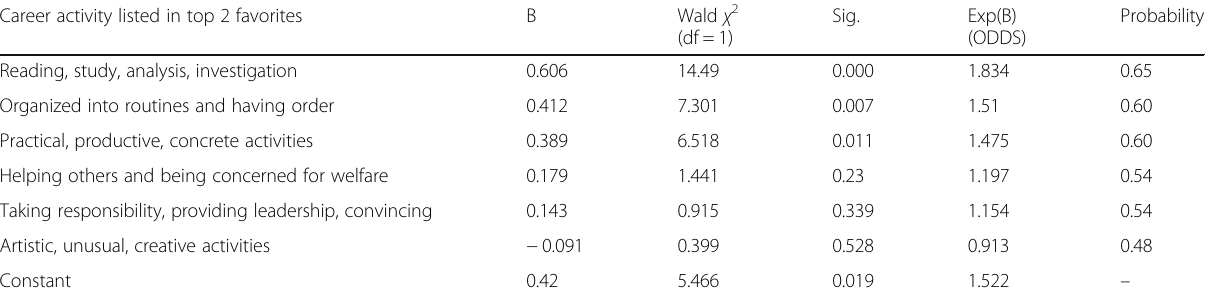
Table 12 Bivariate logistic regression of the influence of career activity preferences on students being very likely to pursue a STEM